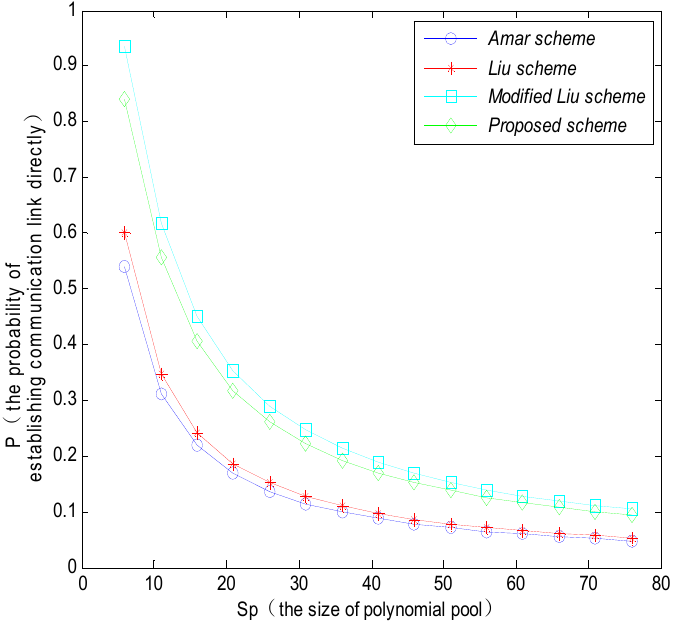
Figure 7. The probability that MS and sensor nodes directly establish the communication link with different schemes.